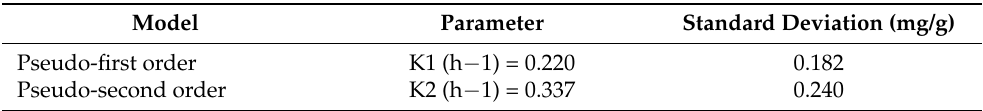
Table 4. Parameters and standard deviation of kinetics models for adsorption of the optimized formulation on sandstone rock.